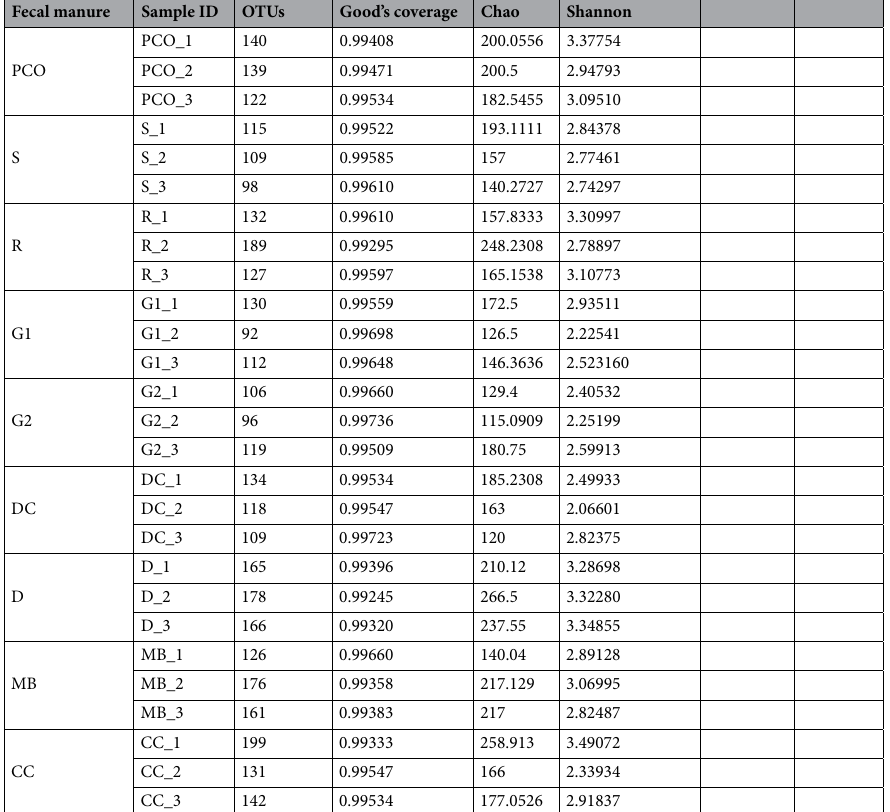
Table 2. Good’s coverage indices (estimated sequencing coverage) and alpha diversity indices of bacterial taxonomic profiles by 16S rRNA gene sequences at the (a) genus and (b) species